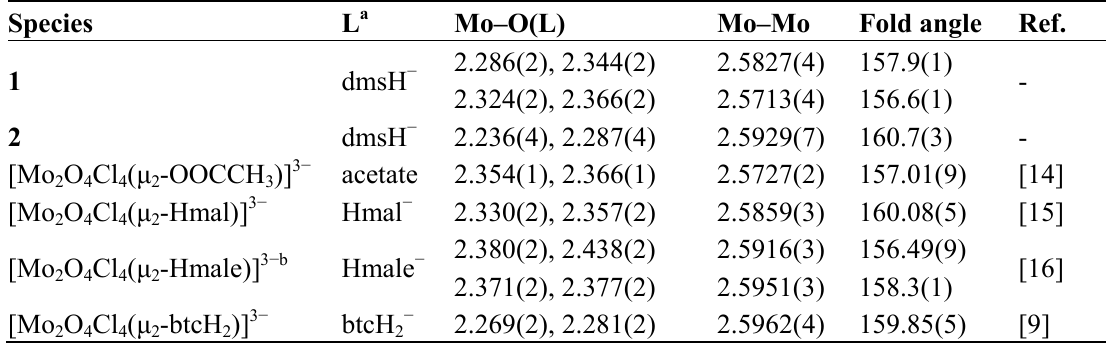
O } 2+ units in carboxylate 2 4